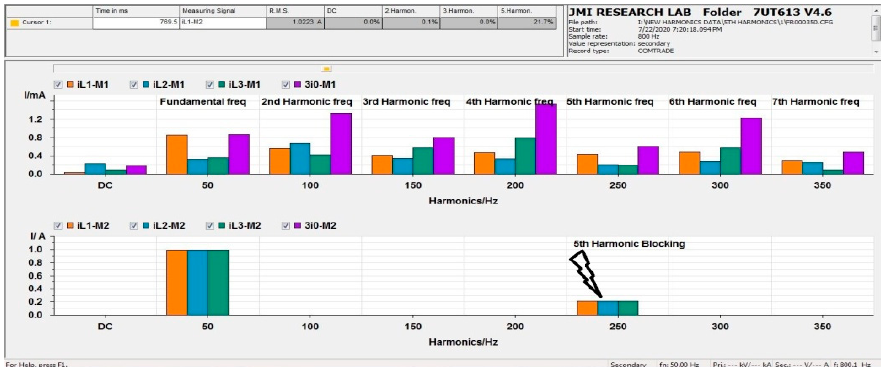
Figure 23. 5th HB at 1000 mA Rated current & 35% of Inrush current condition.